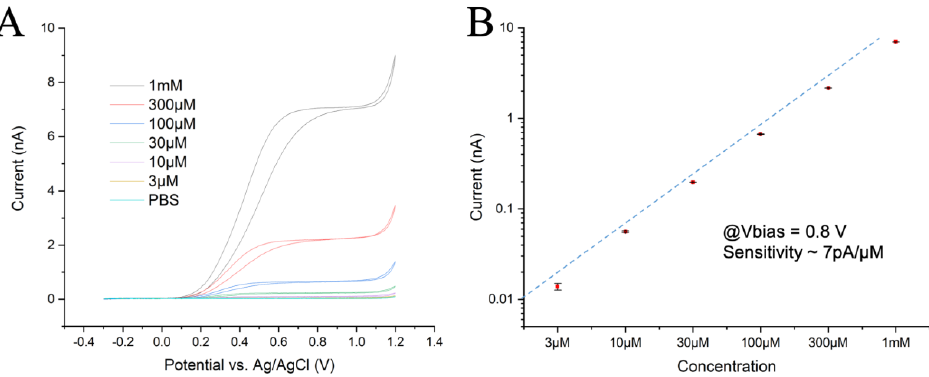
Figure 1. ( A ) CV plots recorded at 50 mV/s with 6 different concentrations of adrenaline. ( B ) Current intensities measured at 0.8 V during the rising ramp, with a linear fit. The electrochemical activity drops slightly at the highest